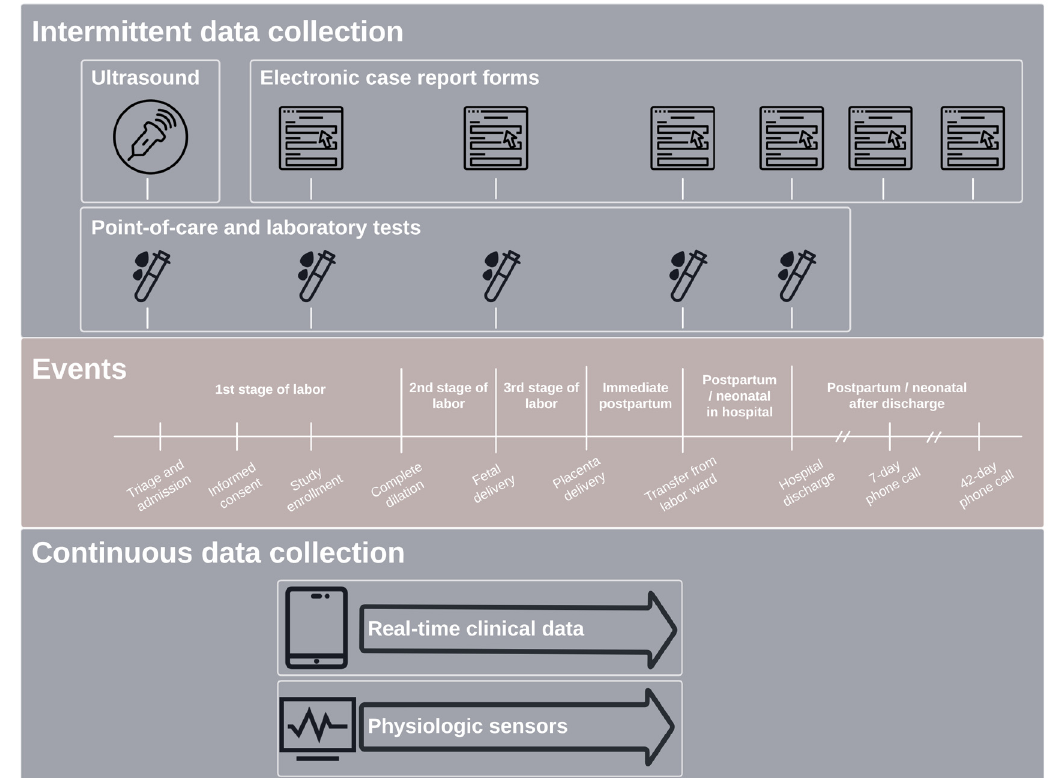
Figure 2. LABOR Study data